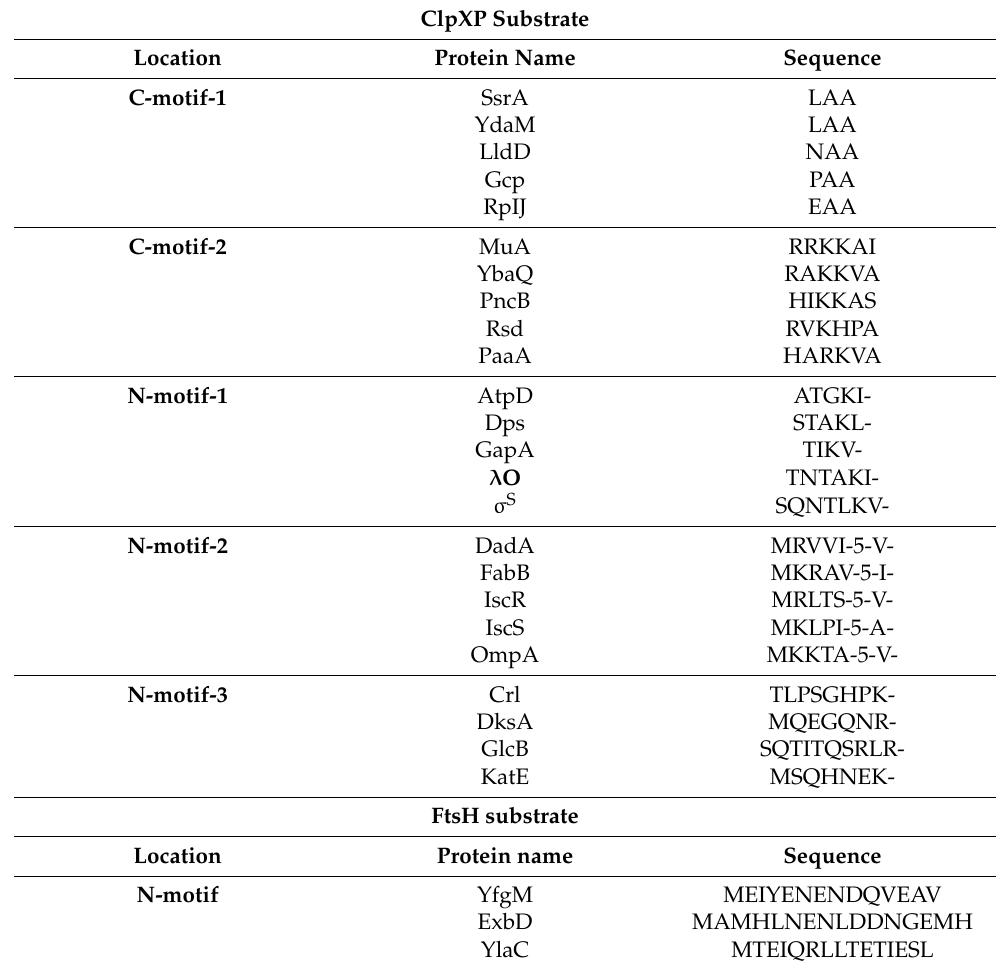
Table 2. Five distinct tags of ClpXP degradation substrate and similar motifs of FtsH degradation substrate identified from E. coli by proteomic